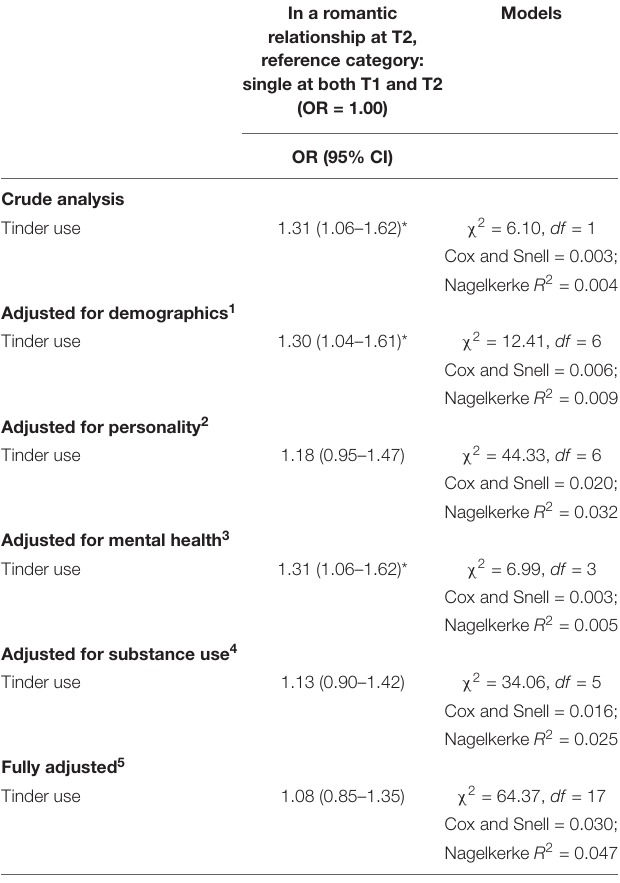
TABLE 3 | The association between Tinder use and romantic relationship formation.